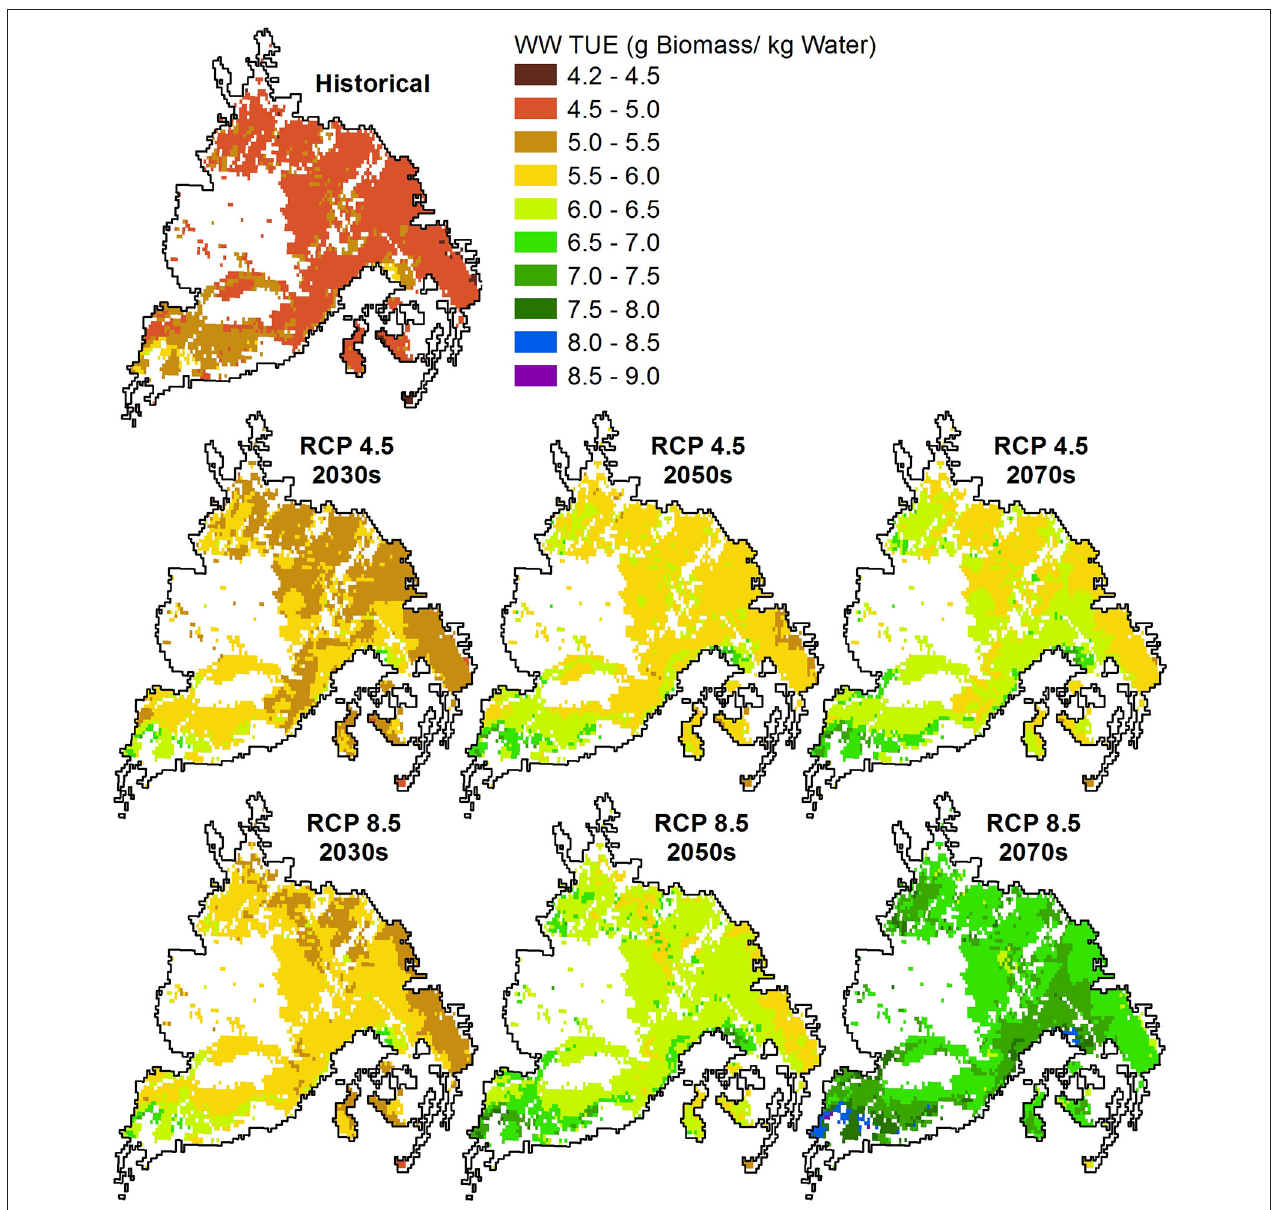
FIGURE 3 | Spatial distribution of winter wheat (WW) transpiration-use efficiency (TUE) in the Inland Pacific Northwest during historical and future periods under 2 representative concentration pathways (RCP), 4.5 and